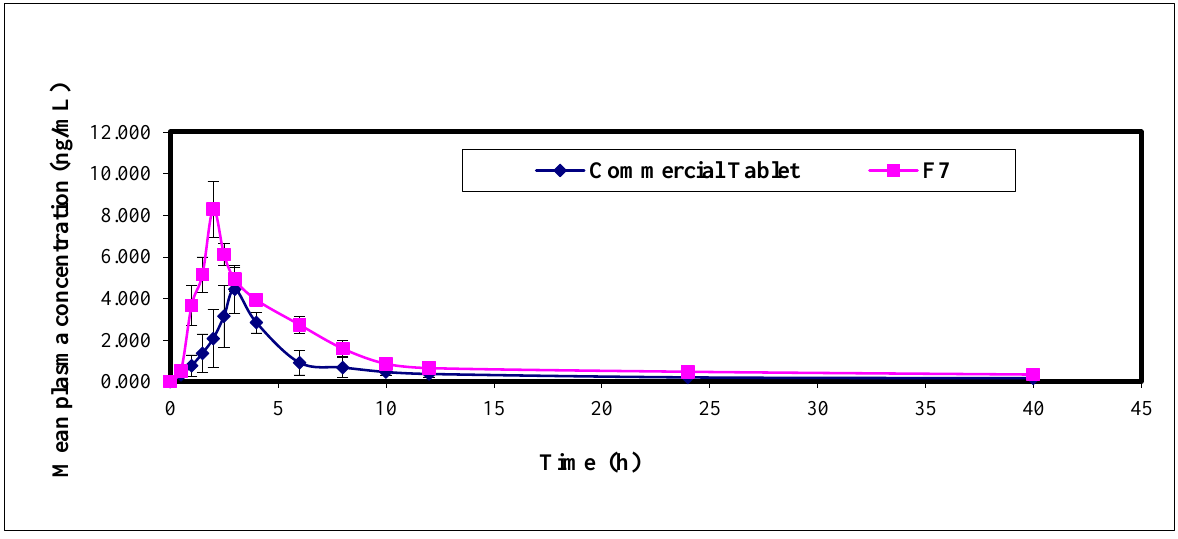
Figure 5. The mean plasma concentration time profiles of BH following iontophoretic transdermal delivery of F7 and single oral administration of Concor ® tablets to six human volunteers. Table 5. Mean pharmacokinetic parameters of BH following transdermal iontophoretic permeation of F7 and oral administration of Concor ® tablets to six human